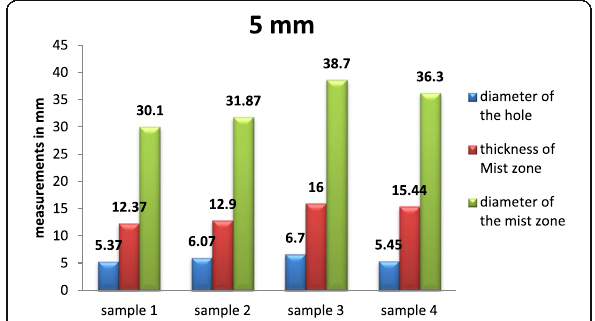
Fig. 9 Fractured glass panes of 4 mm thickness Privacy Glass (left), 4 mm thickness Transparent glass